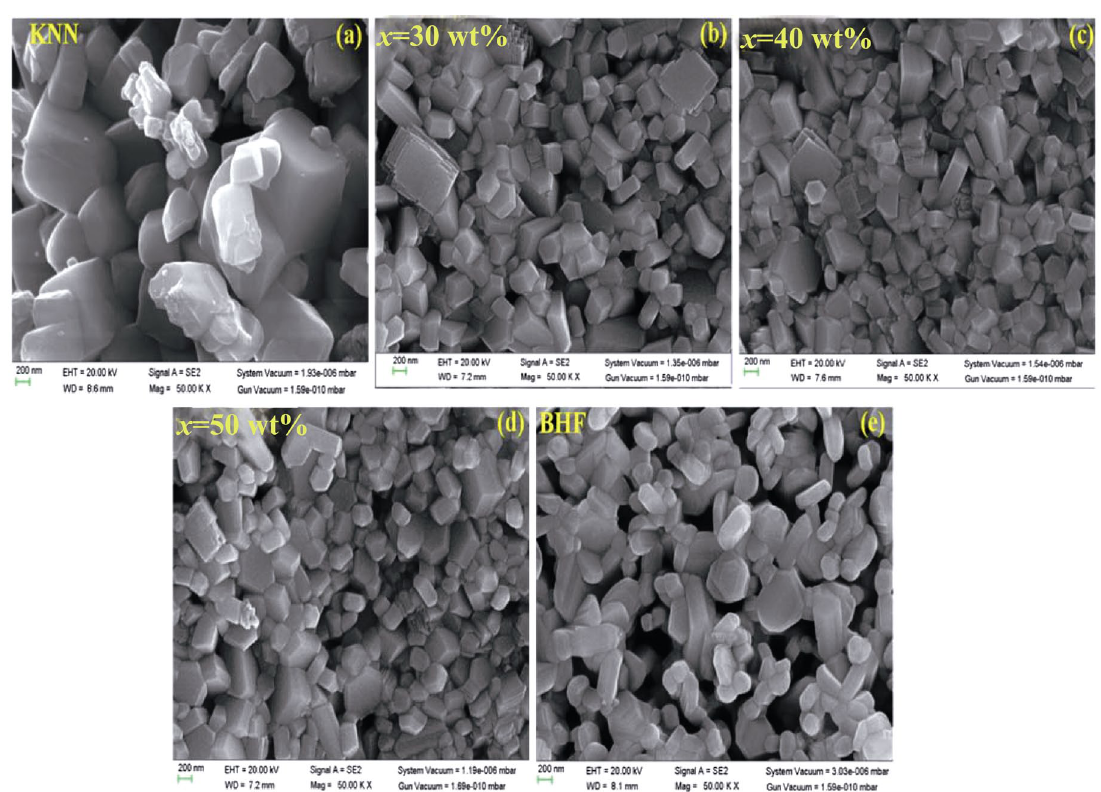
Fig. 2 FE-SEM micrographs of (1 ̶ x )KNN–( x )BHF composites: (a) KNN, (b) x = 30 wt%, (c) x = 40 wt%, (d) x = 50 wt%, and (e) BHF.